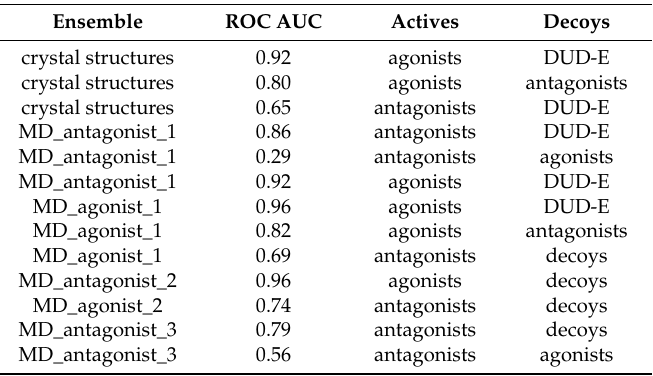
Table 2. Docking performances of the different ensembles against various sets of actives and decoys.